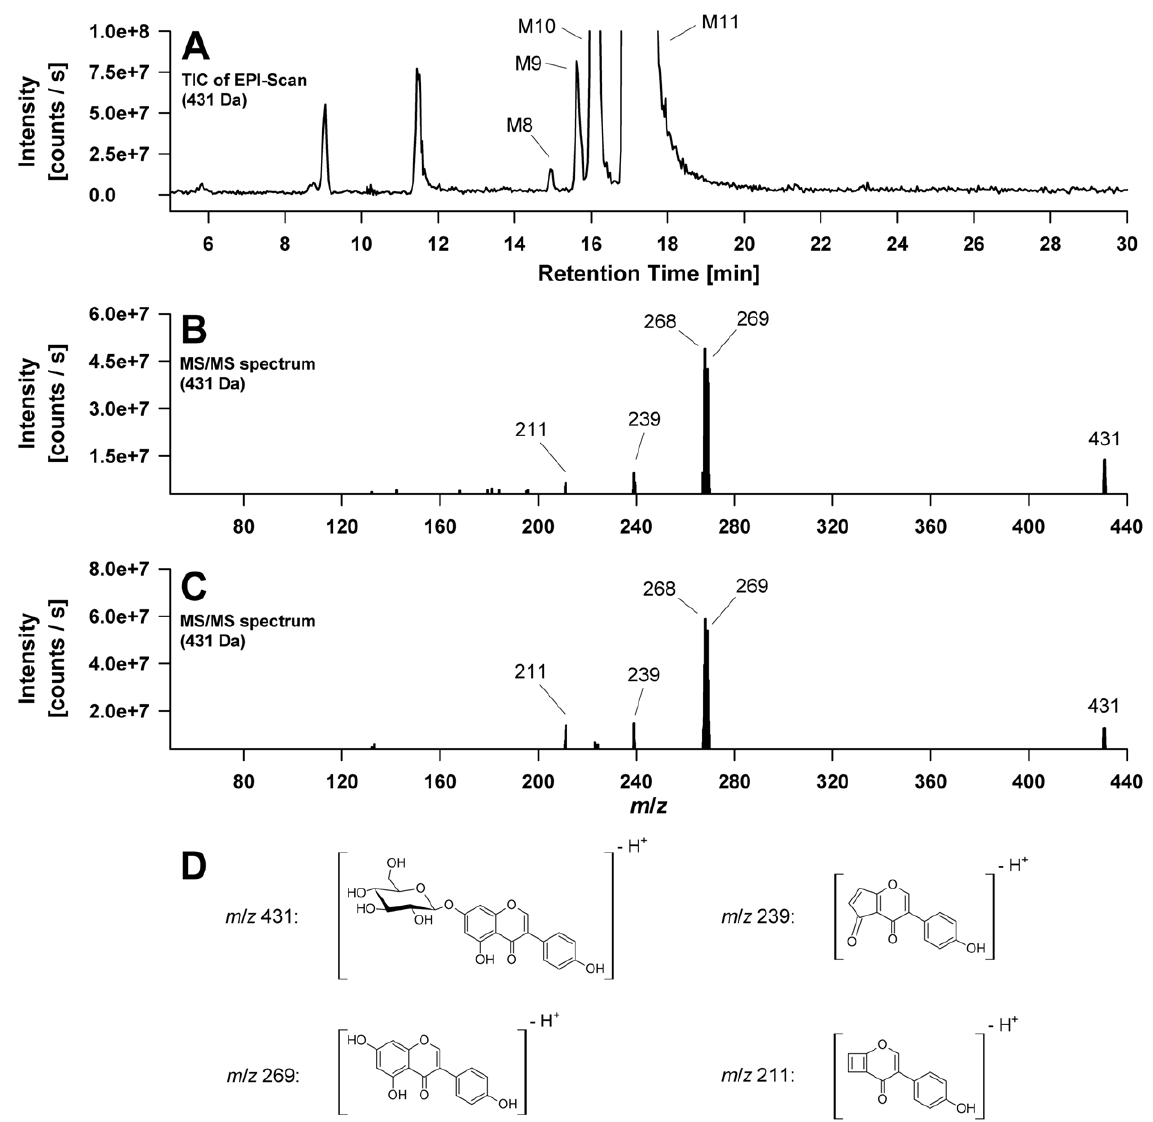
Figure 2. Electrospray mass spectrometric detection (QTrap system) of genistein- O -monohexosides formed by C.elegans . (A) Total ion chromatogram (TIC) of the enhanced product ion (EPI) scan of the m/z 431 precursor showing four genistein- O -monohexoside metabolites. The two major ones are named M10 and M11; two additional minor metabolites are marked as M8 and M9. (B) MS/MS spectrum of the standard compound genistein-7- O -ß-D-glucoside. (C) MS/MS spectrum of metabolite M10, identified as genistein-7- O -ß-D-glucoside using the corresponding standard compound. (D) Proposed structures of the fragment ions observed in the MS/MS spectra shown under (B) and (C).